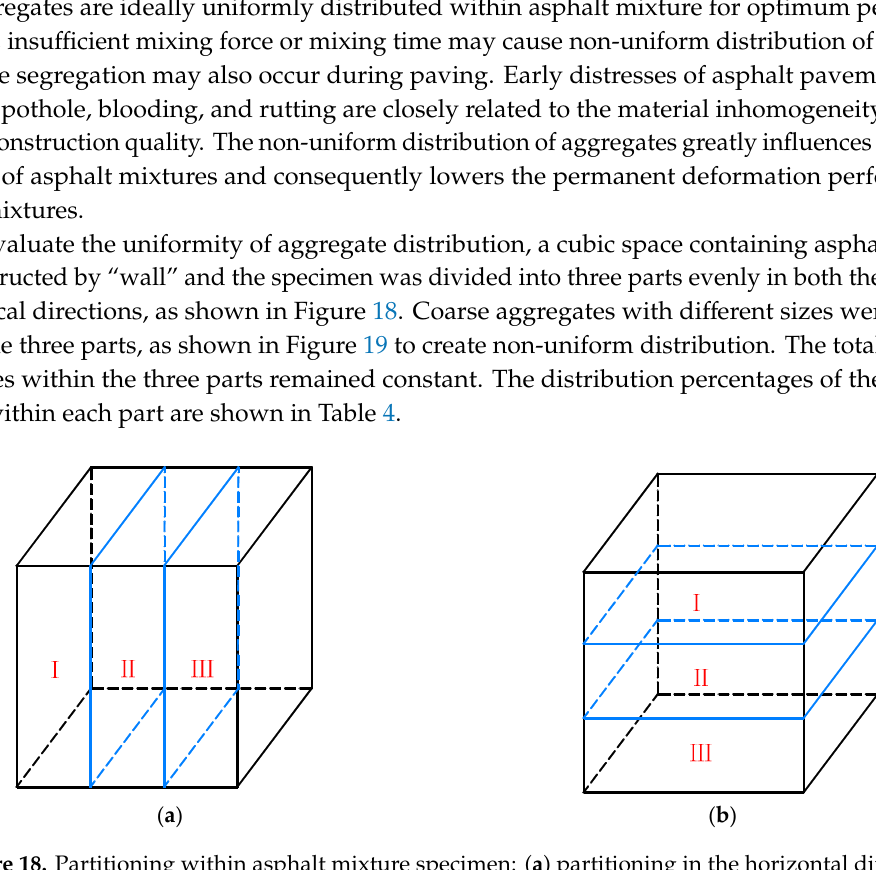
Figure 18. Partitioning within asphalt mixture specimen: ( a ) partitioning in the horizontal direction; ( b ) partitioning in the vertical direction.